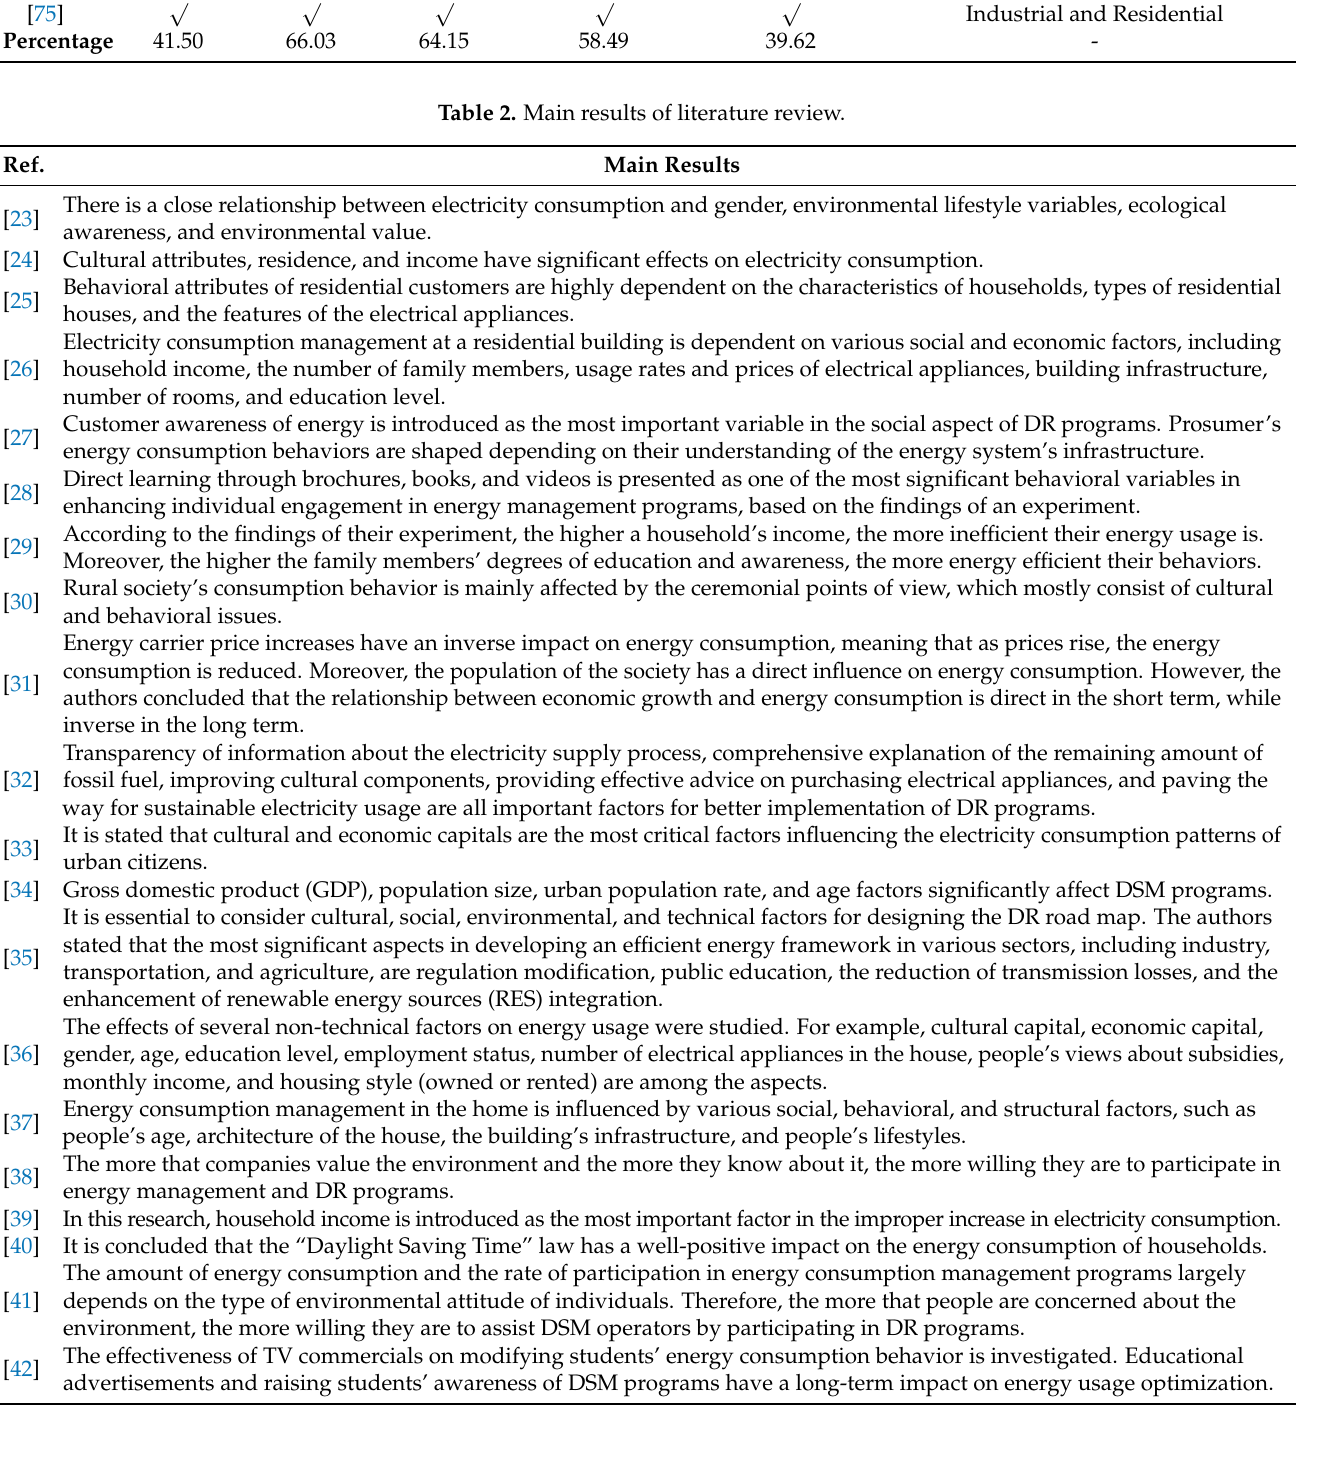
Table 2. Main results of literature